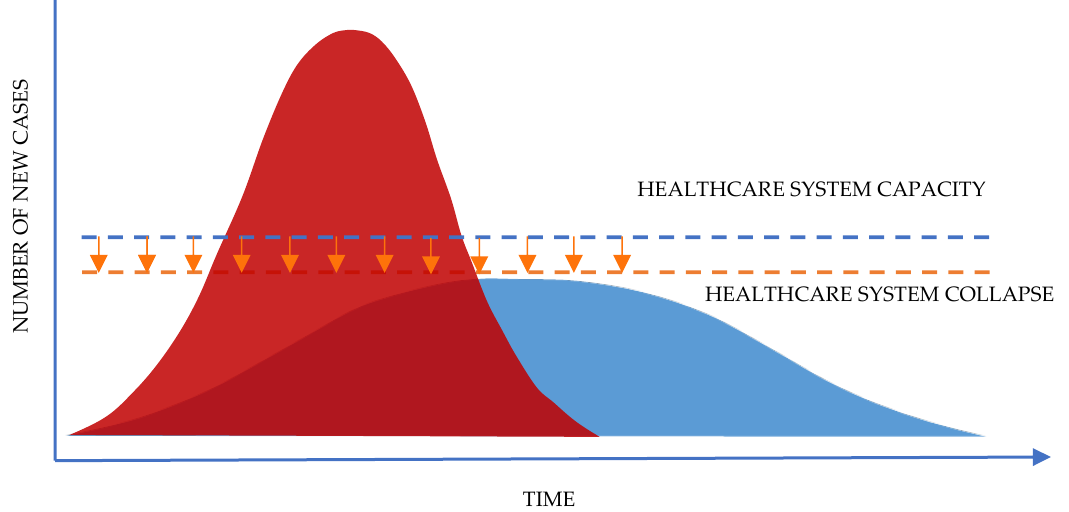
Figure 2. Healthcare system capacity and possible new cases.